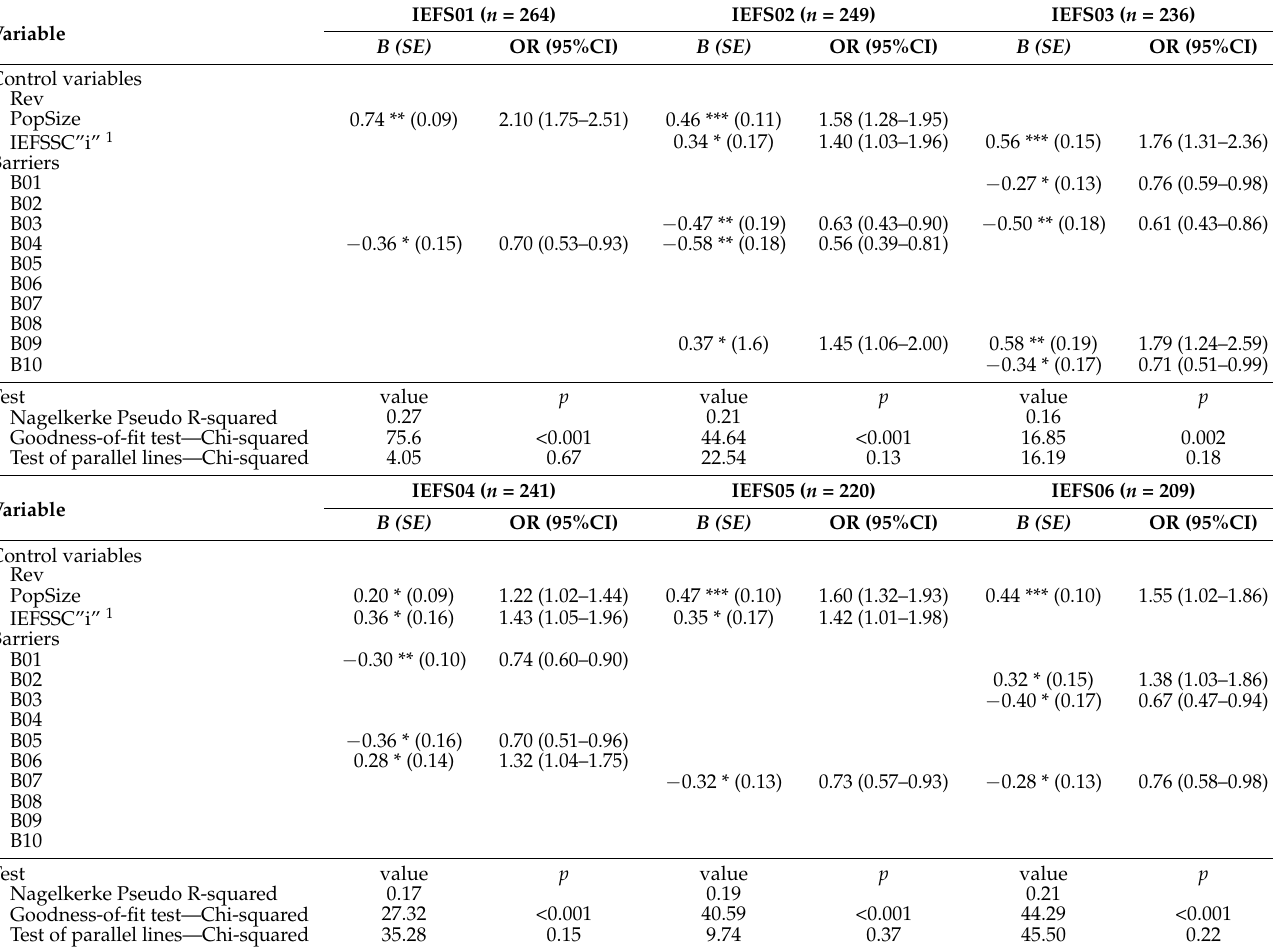
Table 2. Backward stepwise ordinal logistic regression analysis